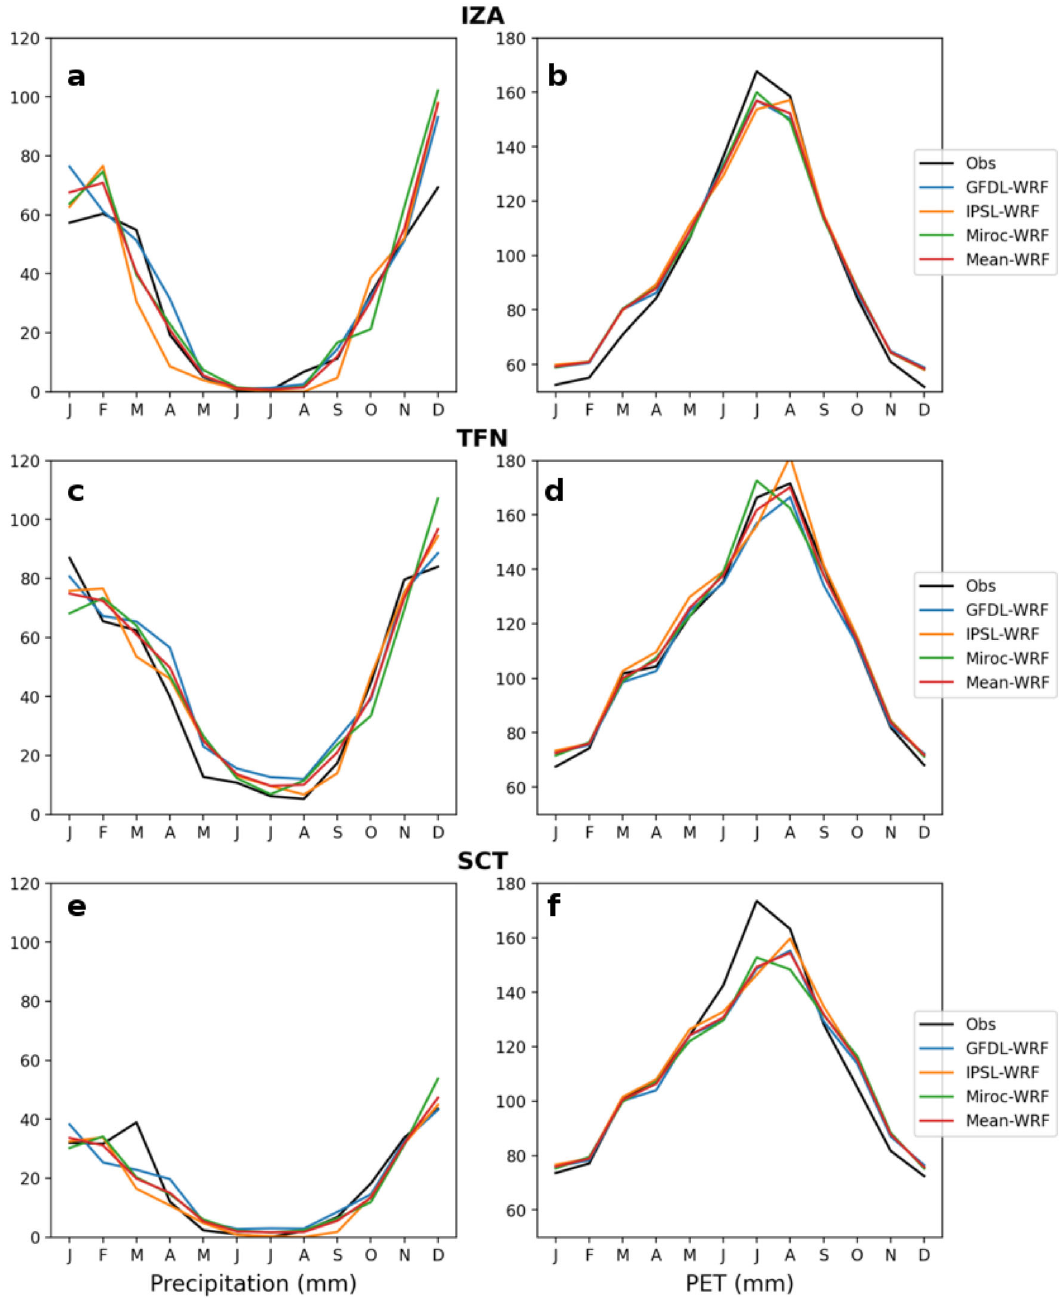
Fig. 1 Skills of WRF simulations to reproduce recent past precipitation and evapotranspiration. Comparison of precipitation ( a , c , e ) and potential evapotranspiration ( b , d , f ) obtained from observations (black line) and from WRF model results, in the recent past period, 1980 – 2009, in three WMO stations: a , b Izaña (IZA, 2371 masl), c , d Tenerife Norte (TFN, 632 masl), and e , f Santa Cruz de Tenerife (SCT, 46